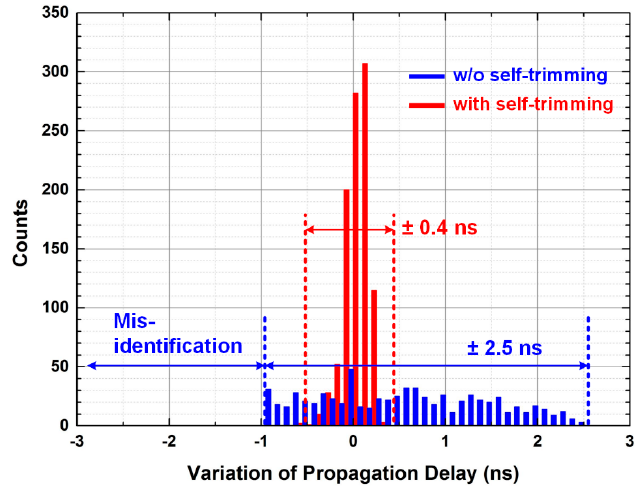
Figure 4. Monte-Carlo simulation results with and without self-trimming.